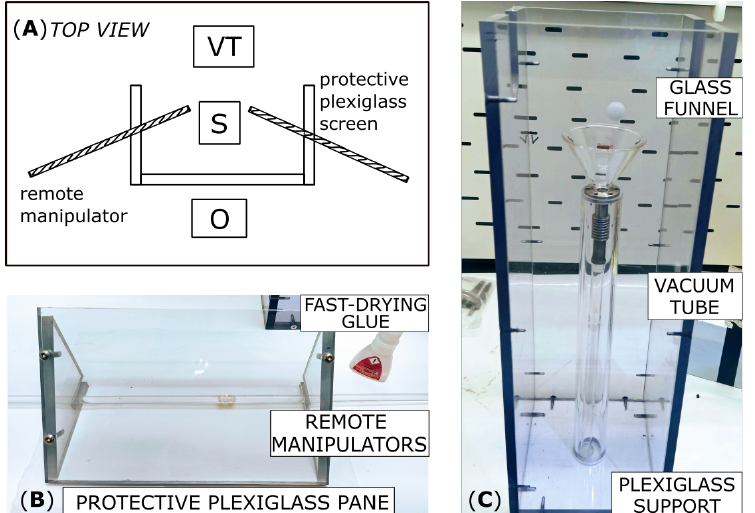
Figure 3. ( A ) Schematic of the opening setup. Operator (O) stands behind the protective panel and manipulates the source (S) with remote manipulators. The source is transferred to a glass tube that is then installed in the vacuum-tight experimental setup (labelled vacuum tube or VT in the schematic). ( B ) The tools for safe handling of the source included: the acrylic remote manipulators with grooves machined to the size of the gelatin shell, the acrylic shielding panel (thickness 1 cm) stopping beta particles from the 131 I source, and the fast-drying glue necessary for the rapid attachment of the gelatin shell to the grooves in the acrylic manipulators. ( C ) The acrylic support for the vacuum tube: a borosilicate glass annealing tube with a CF 16 flange. A glass funnel aids powder transfer and minimizes transfer